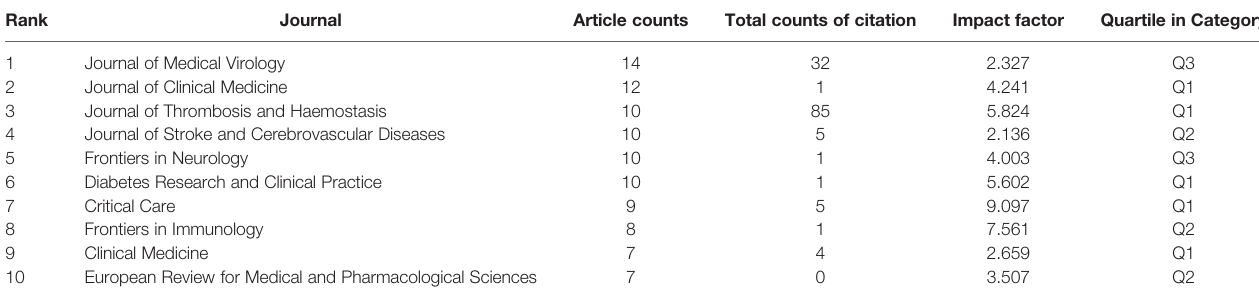
TABLE 2 | The top 10 journals that published articles in COVID-19 complication and sequelae research sorted by article